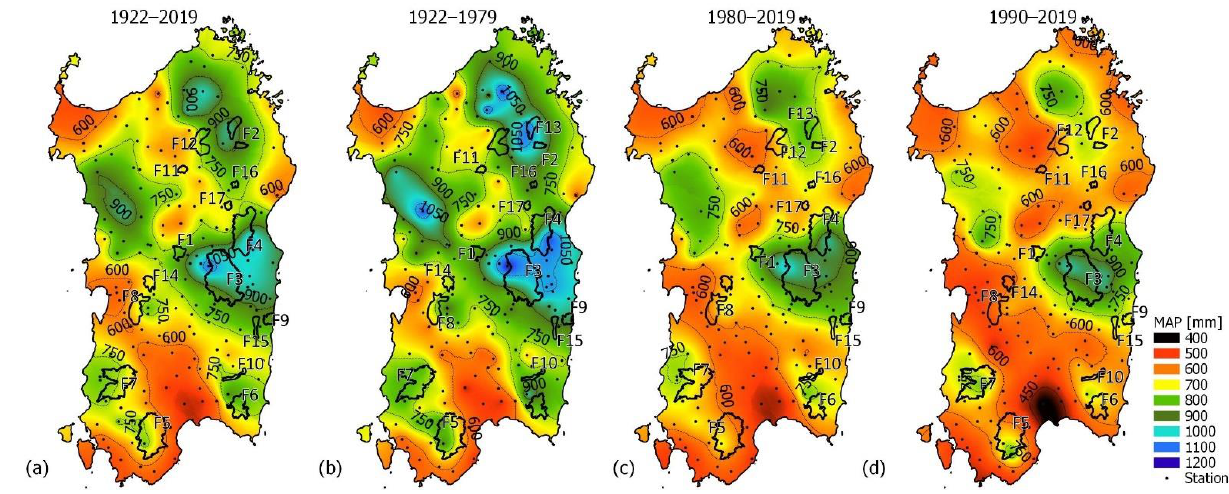
Figure 2. Interpolated mean annual precipitation at 250 m resolution and stratification into 9 equal precipitation intervals: ( a ) over the whole observation period (1922‒2019); ( b ) for the period 1922‒1979; ( c ) for the period 1980‒2019, and ( d ) for the period 1990‒2019 . The black dotted lines are the isolines of MAP, and the thin gray lines indicate the 17 forests analyzed (Table 2).